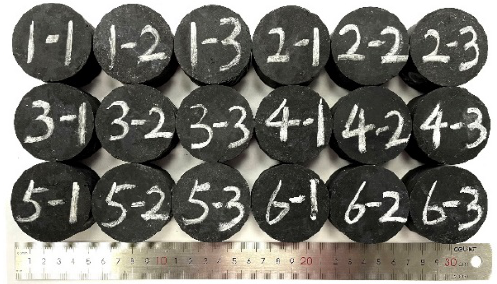
Figure 5. Coal specimens for the